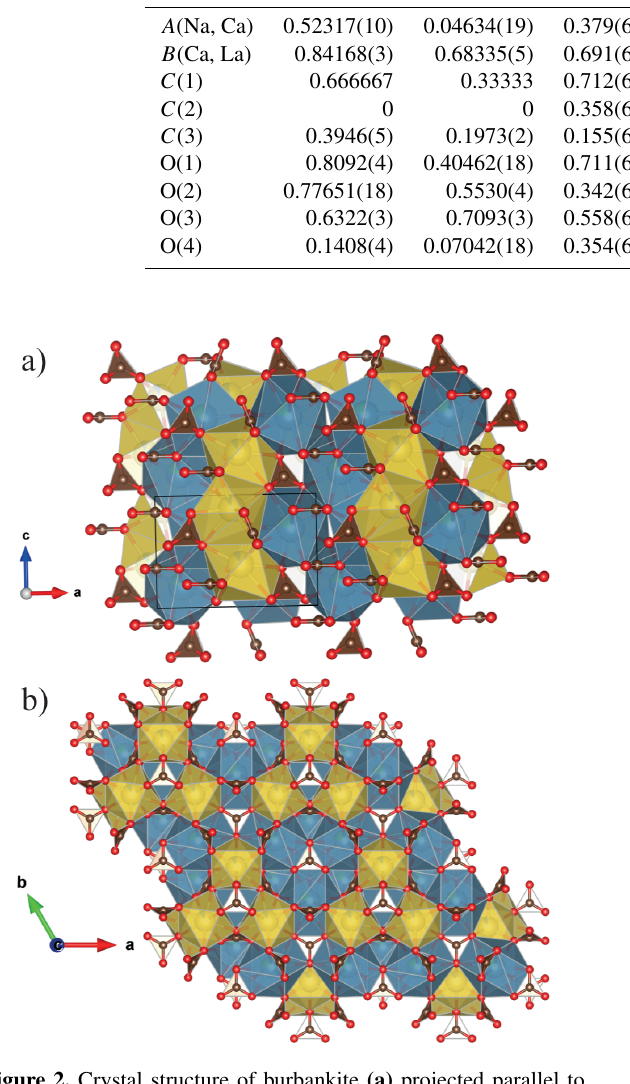
Figure 2. Crystal structure of burbankite (a) projected parallel to [001] the zigzagged AO 8 (yellow) and (b) parallel to (001) where we can observe the 3-fold ring made of BO 10 (blue). The repre- sentations of the structure are realized using the program VESTA (Momma and Izumi, 2011).